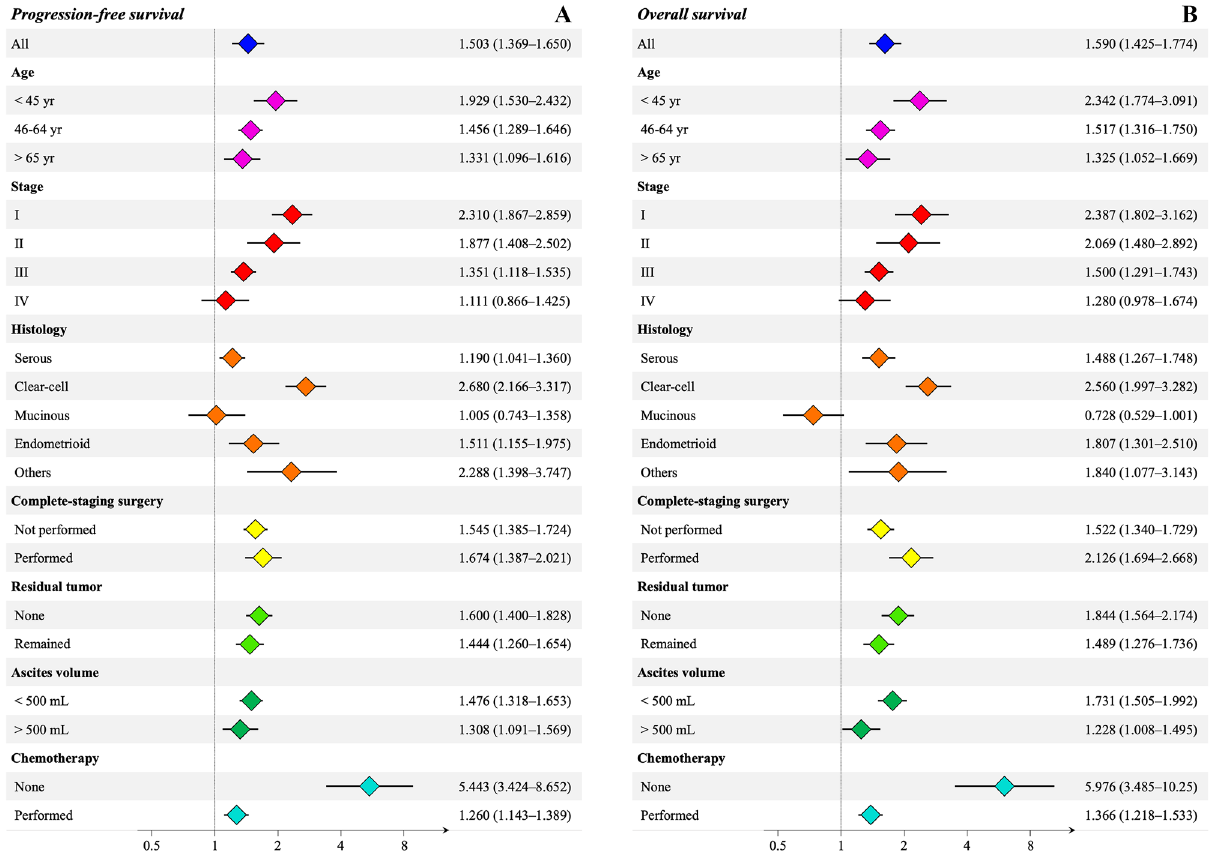
Figure 2. ( A ) Propensity score-adjusted estimation of the hazard ratio of progression ( A ) and death ( B ), and the 95% confidence interval for positive ascites cytology in each subgroup. Propensity scores were created with variables other than those used in each subgroup category.